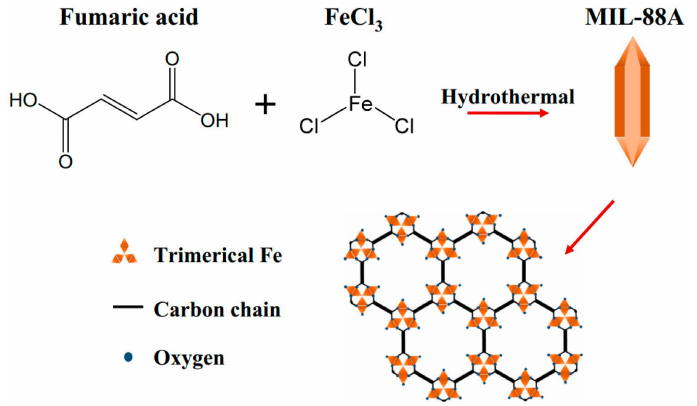
Figure 10. Synthesis method and structure diagram of MIL-88A nanorods. Reprinted with permission from Ref. [107]. Copyright 2018, Springer